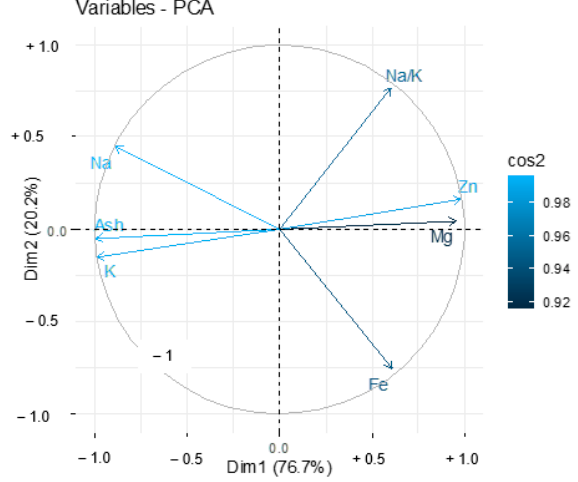
Figure 9. Correlation analysis of different tomato by-product minerals.